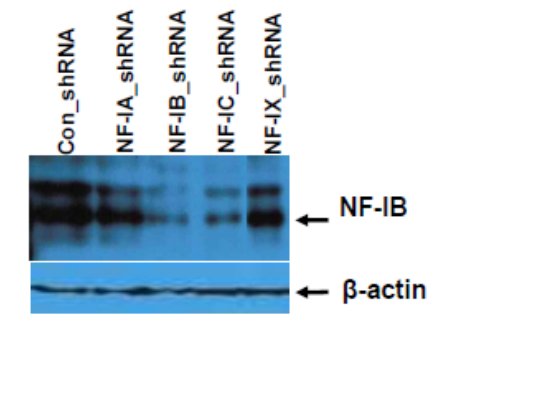
Figure 7. Knock-down of NF-IB in J-Lat-Tat-GFP cells. J-Lat-Tat-GFP-A1 cells were